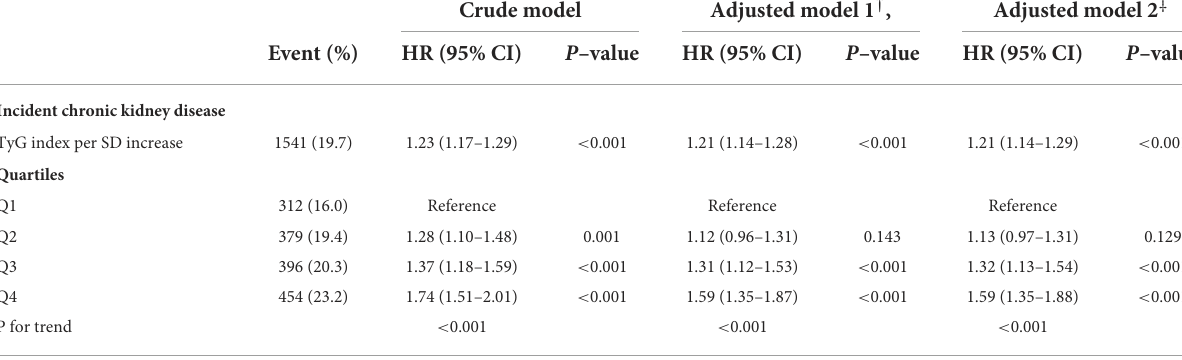
TABLE 2 Association between triglyceride-glucose index and incident chronic kidney disease.